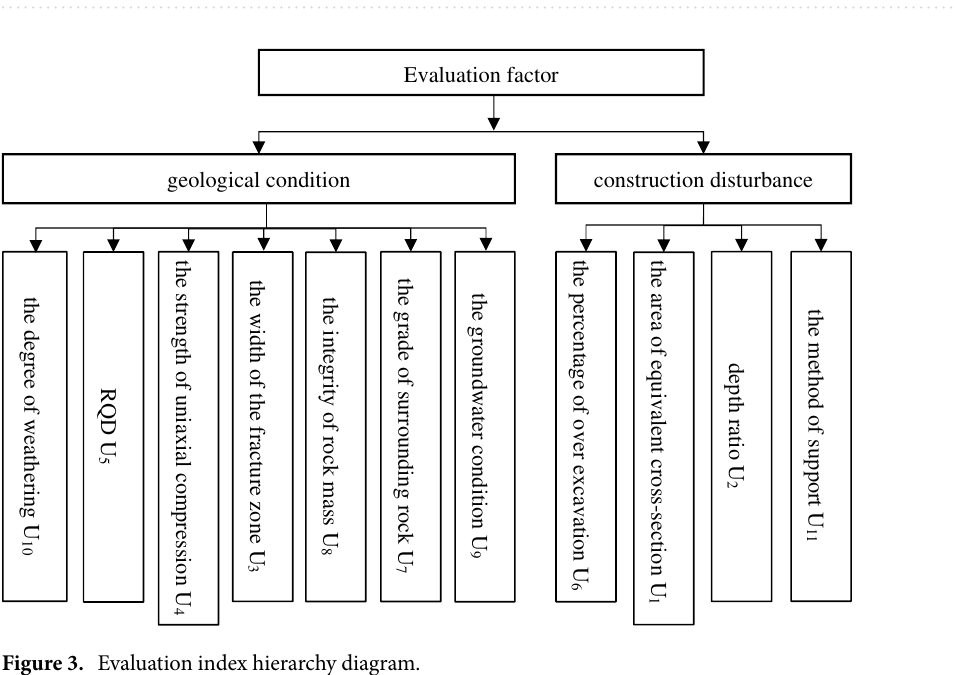
Figure 3. Evaluation index hierarchy